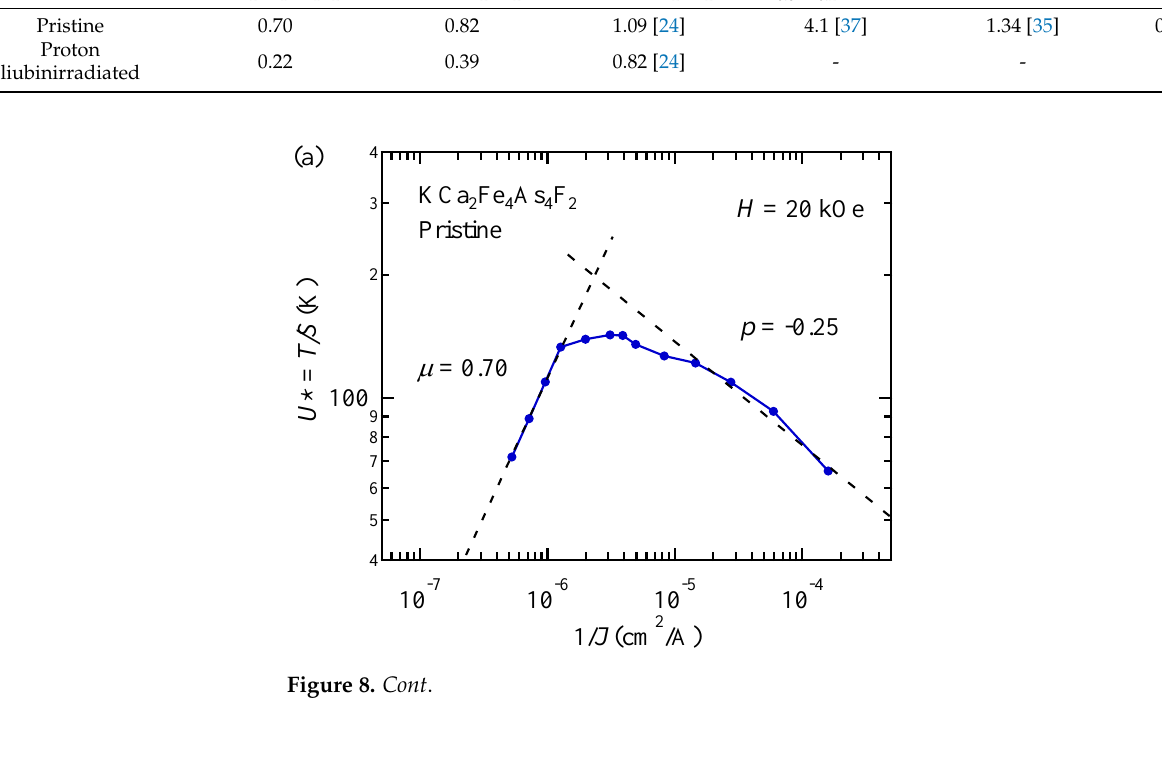
Figure 8. Inverse current density dependence of effective pinning energy U * at H = 20 kOe in ( a ) the pristine and ( b ) 3 MeV proton irradiated (3 × 10 16 ions/cm 2 ) KCa 2 Fe 4 As 4 F 2